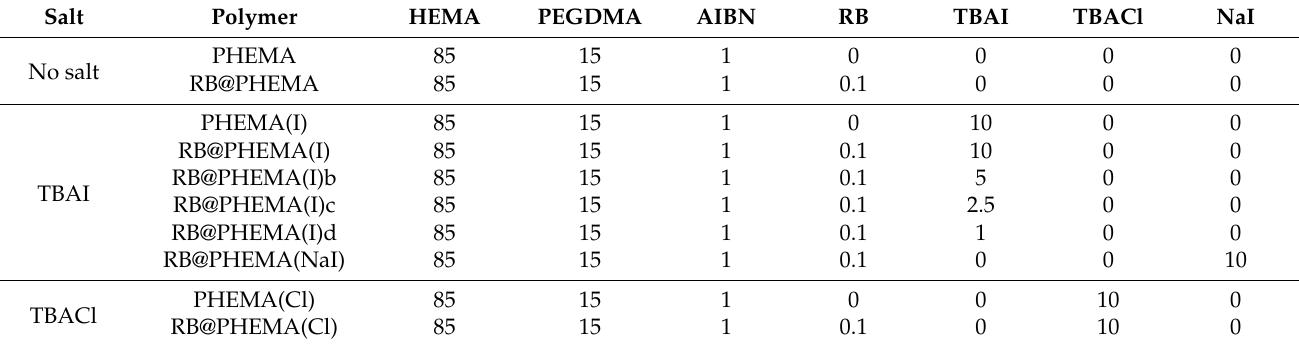
Figure 1. Structures of Monomer (HEMA), Crosslinker (PEGDMA), Photosensitizer (RB) and Tetra- butylammonium Halide Salts Employed to Synthesize the PHEMA Films Described in This Work. Table 1. Formulations (Weight Parts) Used to Obtain PHEMA Films Described in this Study.